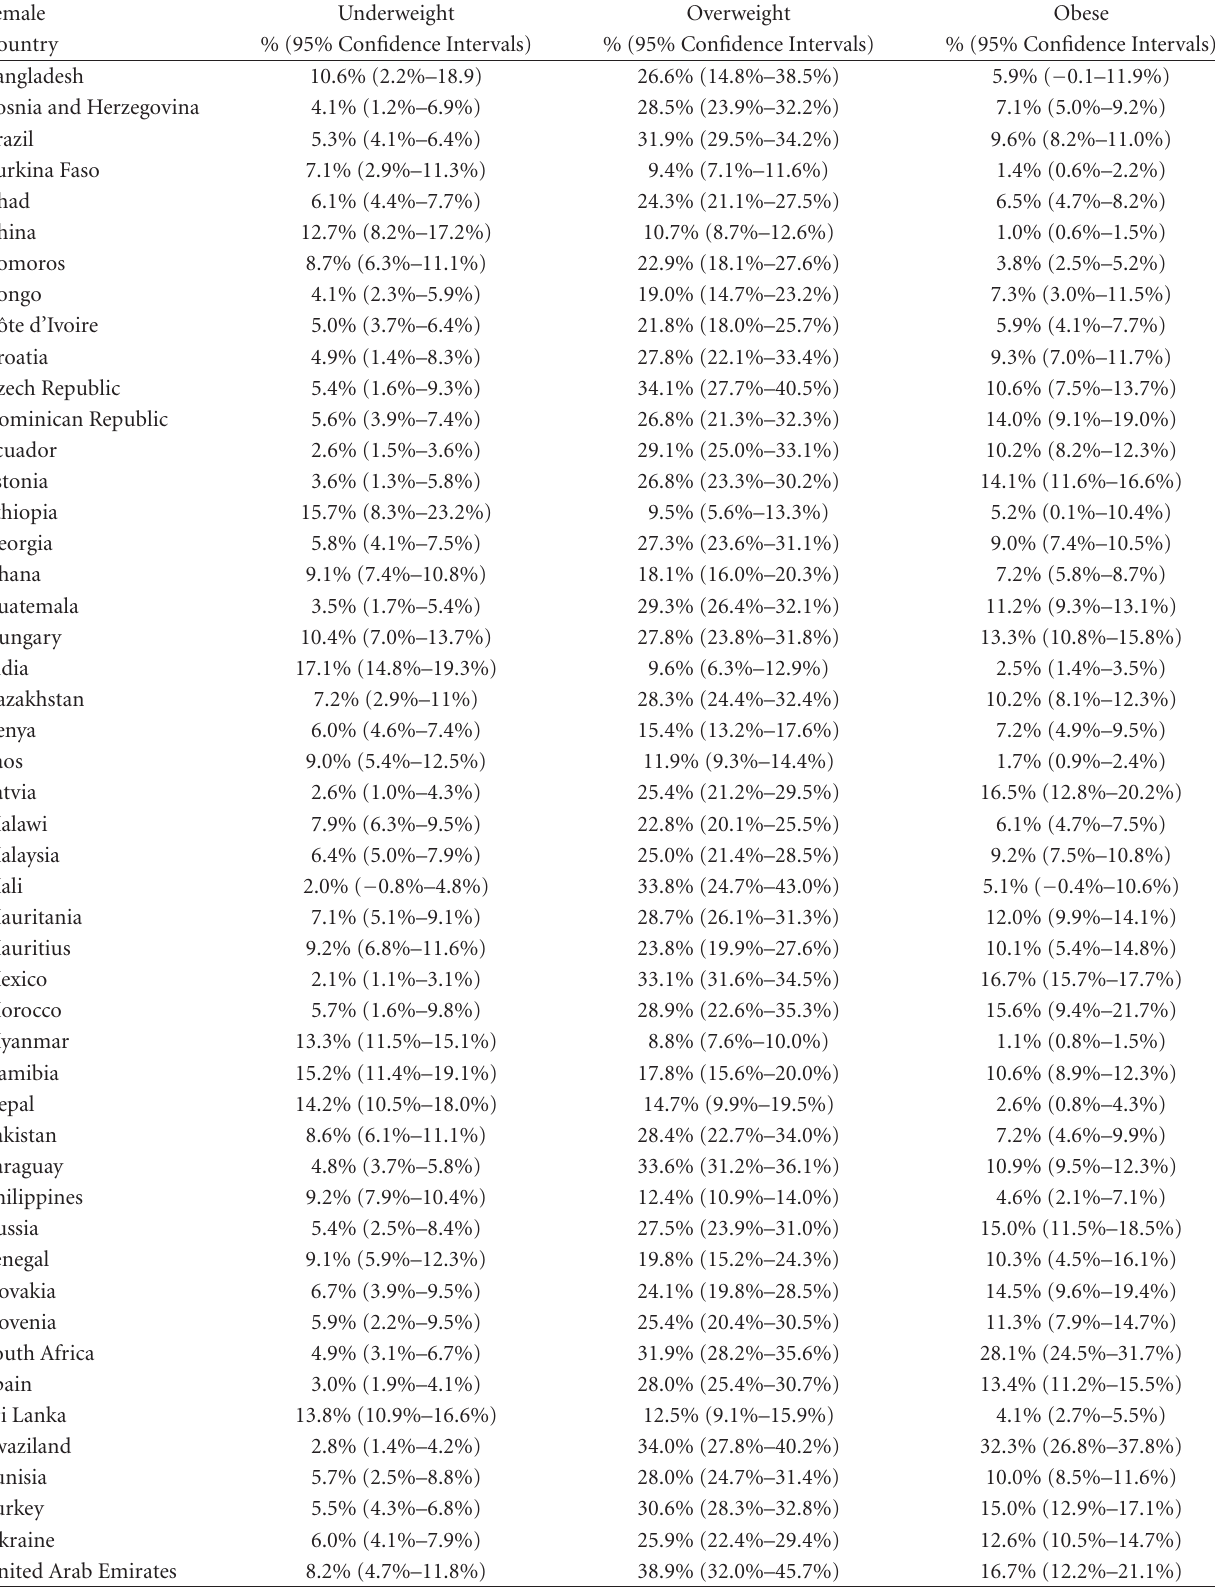
Table 3: Prevalence of body mass index (BMI) classification, by sex (female) and country, WHS,